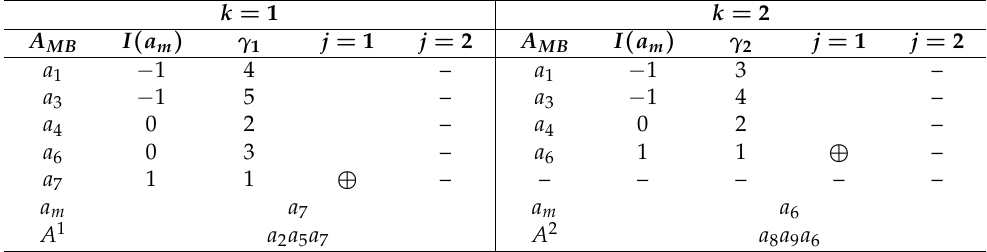
Table 7. Redistribution process for FSM S 1